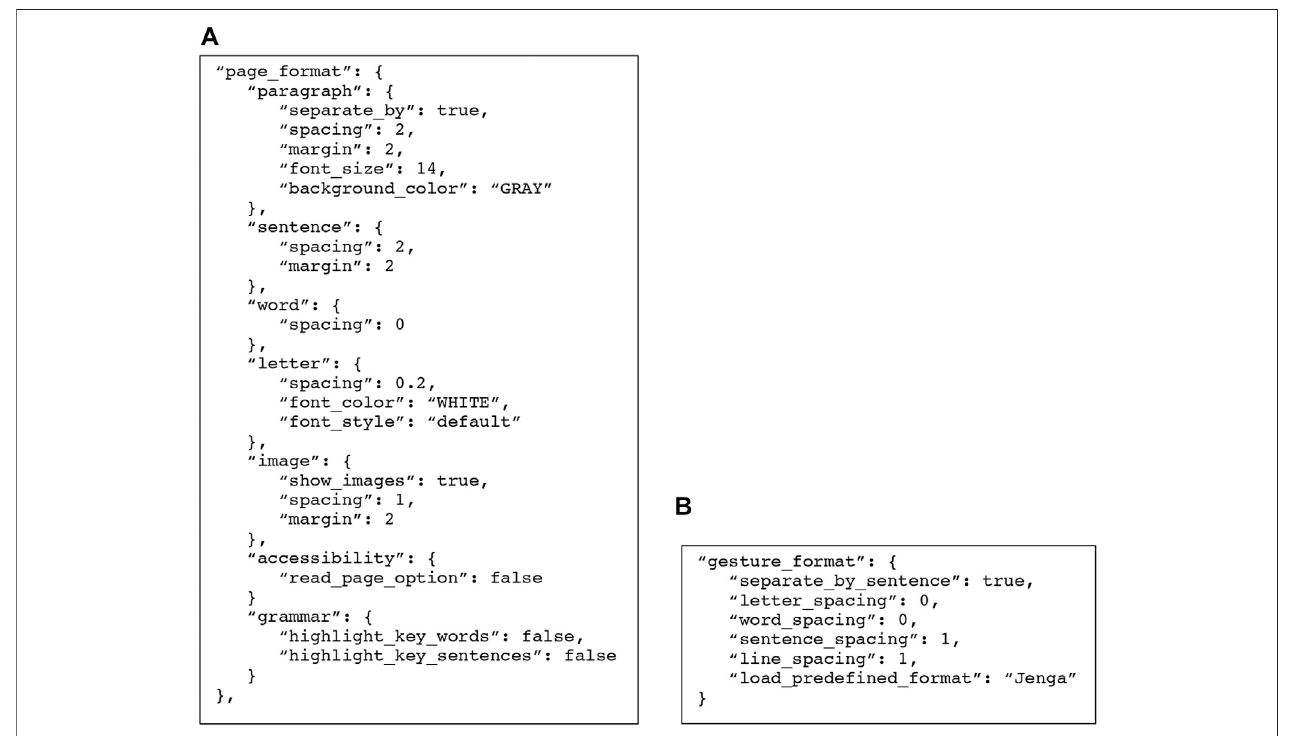
FIGURE 8 | An example of JSON fi le used for con fi guring content presentation (A) : Page Formatting, (B) : Gesture Formatting.